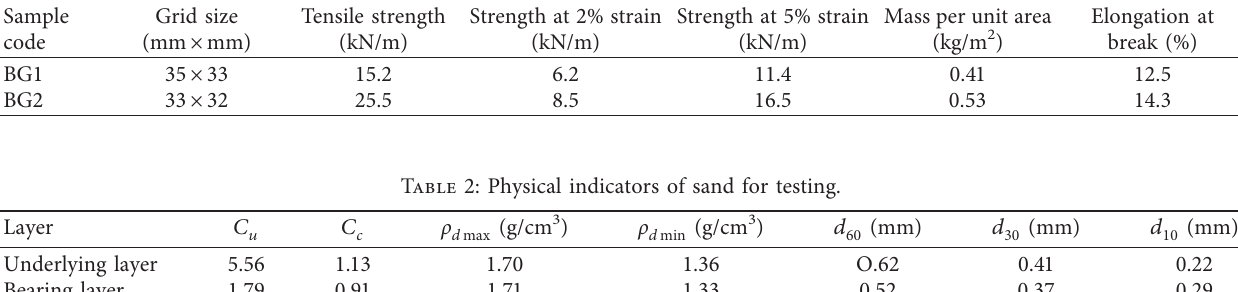
Table 1: Physical property indexes of biaxial